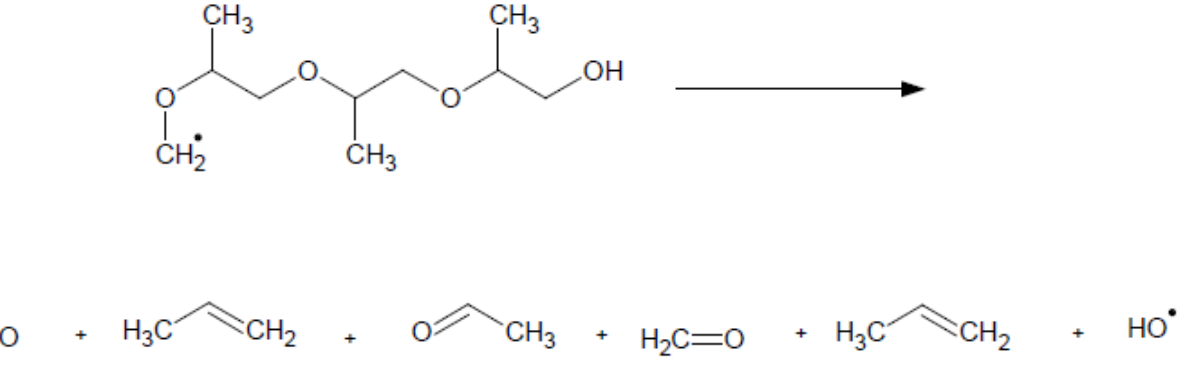
Figure 1. One of the variants of the tripropylene glycol monomethyl ether molecule decomposition in the process of its ignition.